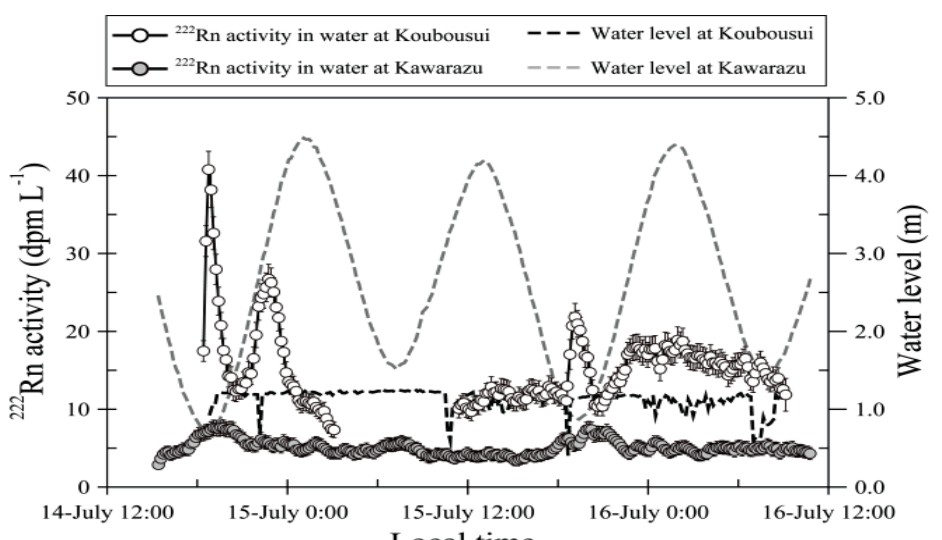
Fig. 4 Temporal changes in 222 Rn and sea level at Koubousui and Kawarazu.